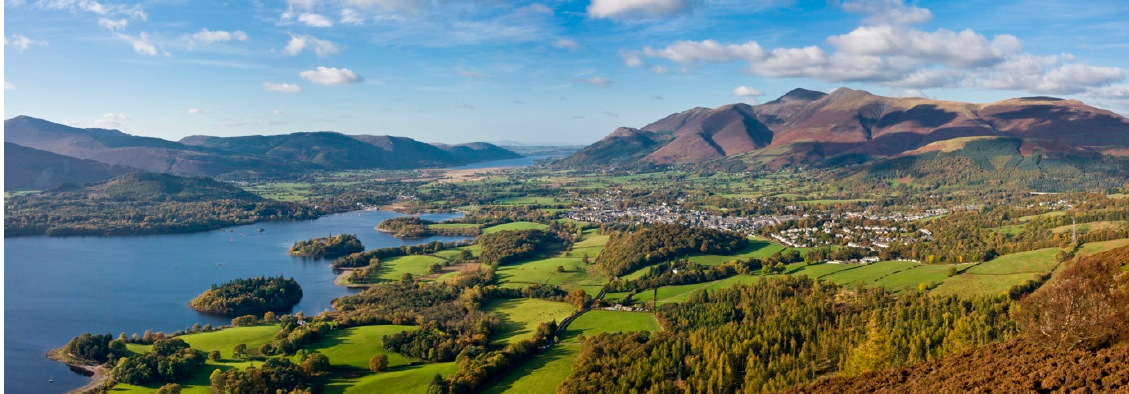
Figure 5. The Keswick Panorama in the scenic Lake District of Cumbria, England. (Photo by David Diliff from Creative Commons). No changes to were made to the photo. Available on line https://upload.wikimedia.org/wikipedia/commons/thumb/a/ab/Keswick_Panorama_-_Oct_2009.jpg/1280px-Keswick_Panorama_-_Oct_2009.jpg (accessed on 22 July 2022). [21]. License: CC BY-SA 3.0. License URL: https://creativecommons.org/licenses/by-sa/3.0/deed (accessed on 22 July 2022).